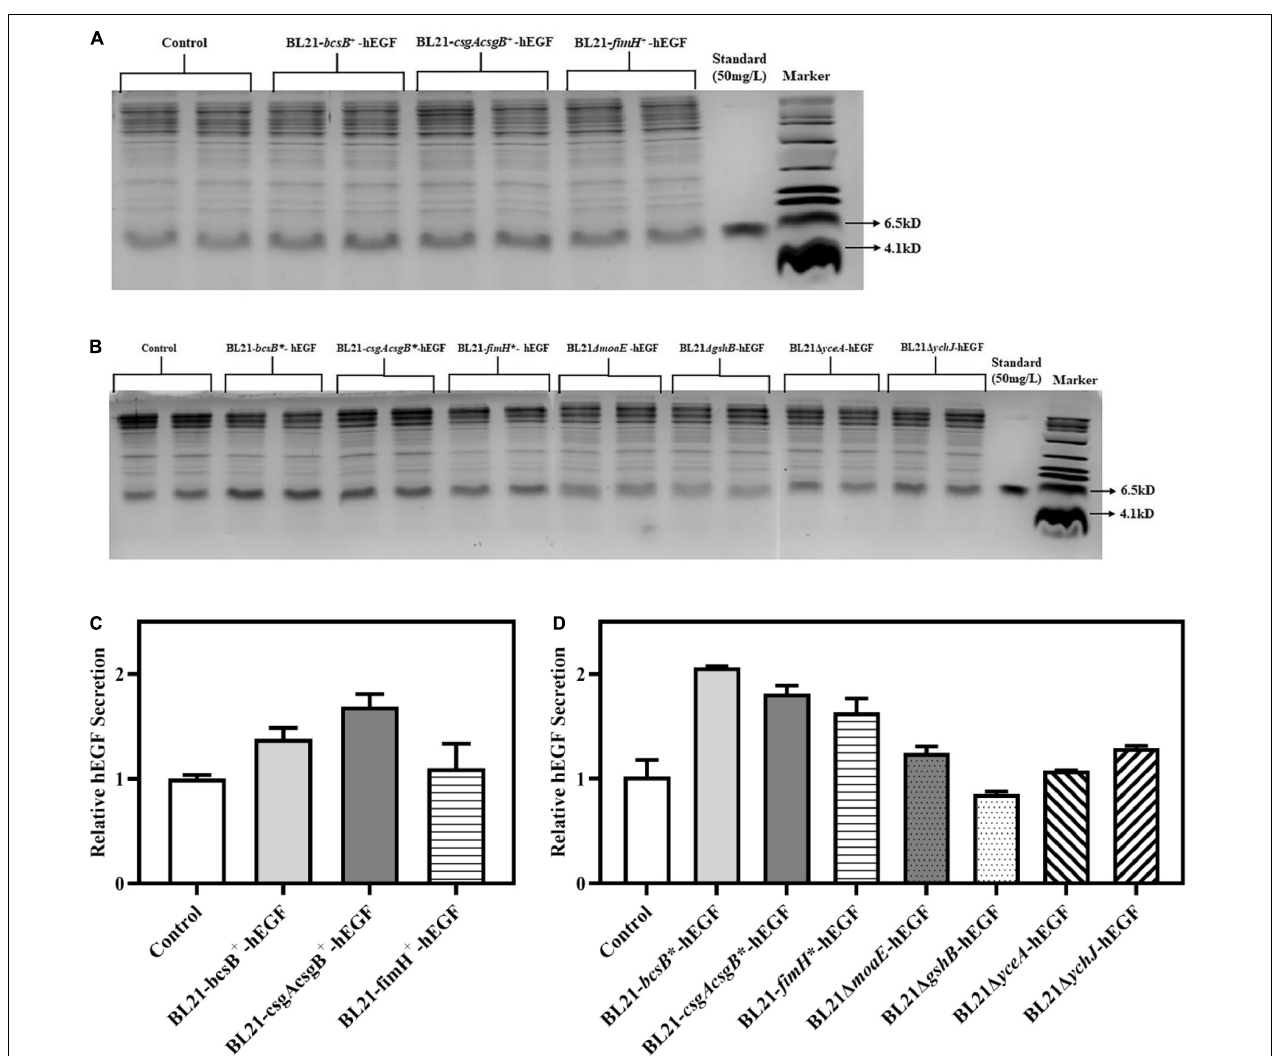
FIGURE 5 | Effects of different gene manipulations on hEGF secretion in free-cell fermentation in LB medium. (A) SDS-PAGE of secreted hEGF in strains with plasmid-based expression of biofilm related genes. (B) SDS-PAGE of secreted hEGF in strains with genome-integrated expression of or disruption of biofilm related genes. (C) Relative hEGF secretion of strains with plasmid-based expression of biofilm related genes. (D) Relative hEGF secretion of strains with genome-integrated expression of or disruption of biofilm related genes. The hEGF secretion levels were normalized to the OD 600 of corresponding